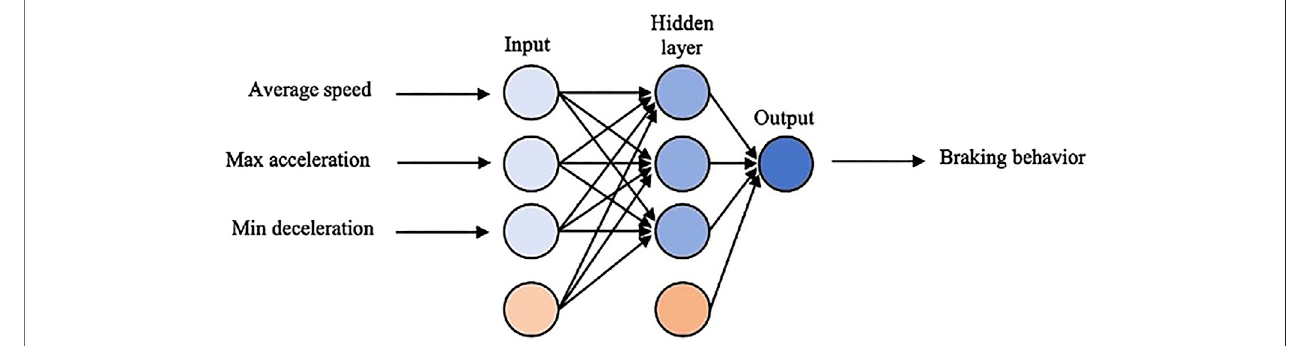
FIGURE 3 | Structure of the proposed ANN classi fi er.